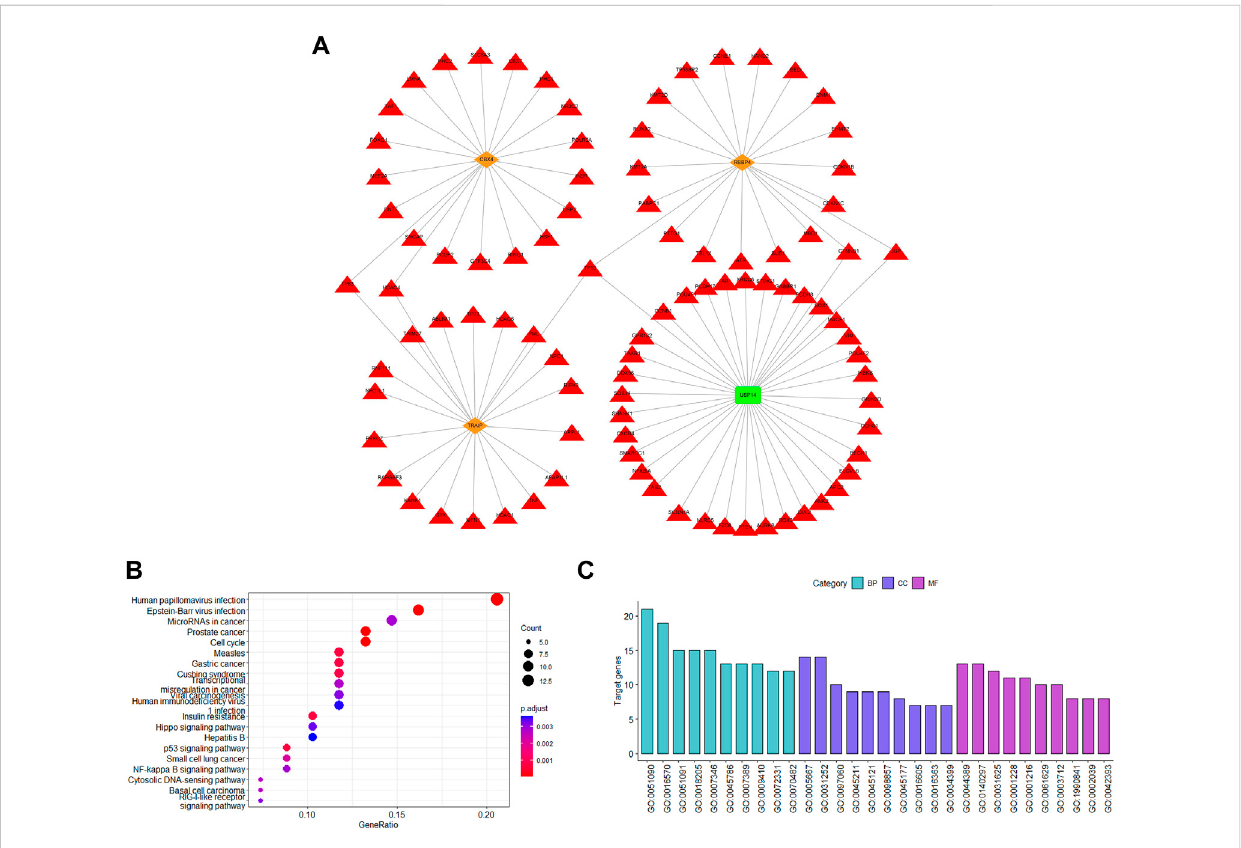
FIGURE 7 Analysis of substrates for ubiquitination-related genes. (A) Top 20 predicted and known substrate proteins. (B) KEGG enrichment analysis. (C) GO pathway enrichment analysis. The red triangle represents the substrate proteins; the orange diamond represents the E3s; and the green rectangle represents the